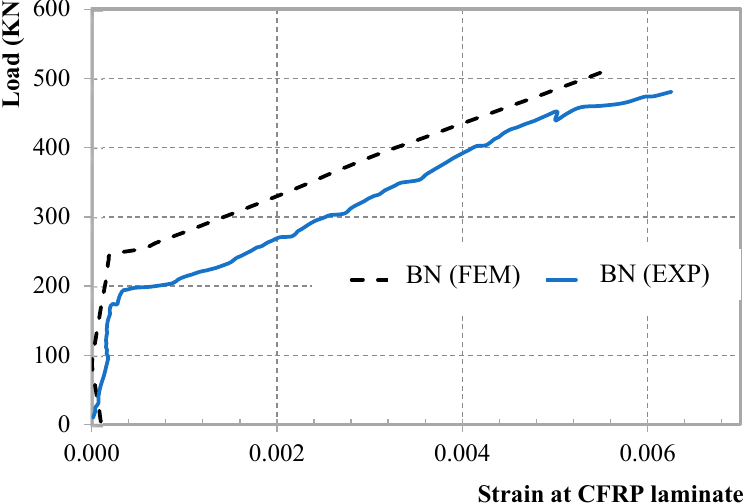
Figure 27. General comparison between EXP and FEM for CFRP strain for BN slab.